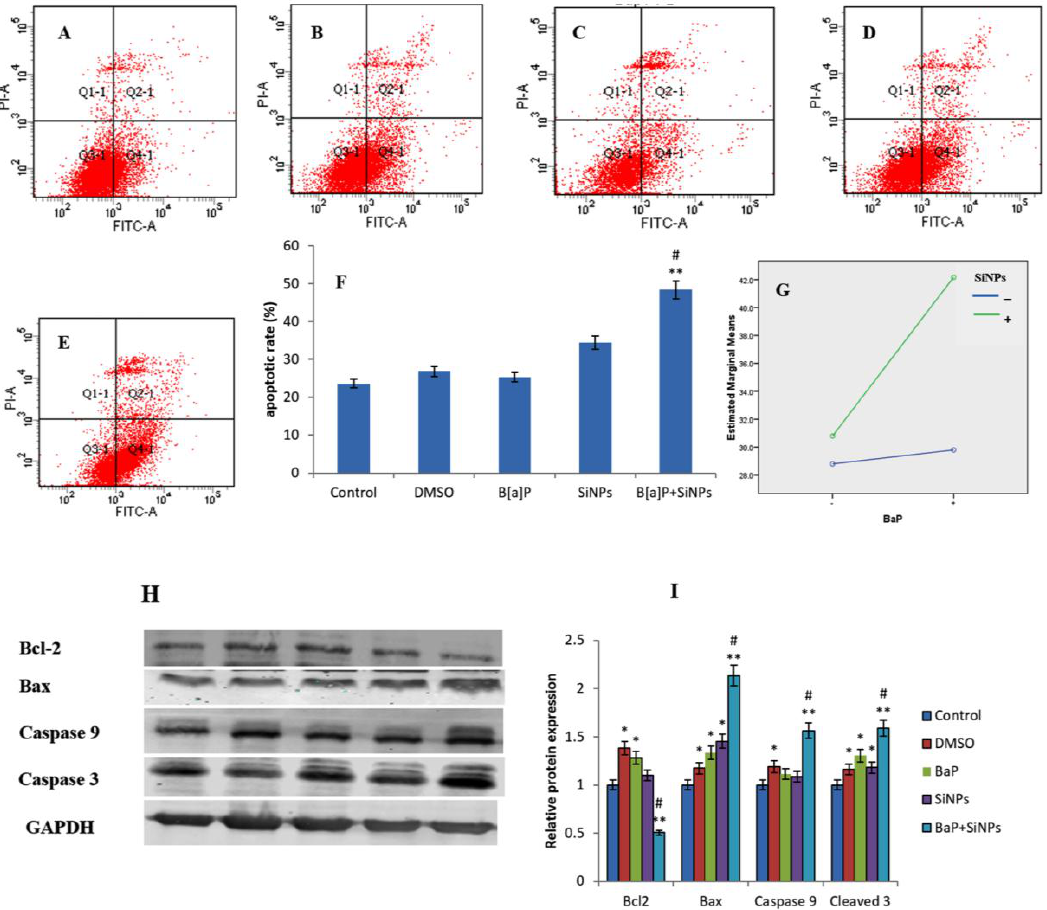
Figure 8. Apoptosis of HUVECs induced by SiNPs and/or B[a]P. ( A ) Control; ( B ) DMSO; ( C ) B[a]P; ( D ) SiNPs; ( E ) B[a]P + SiNPs; ( F ) The percentage of apoptotic cells; ( G ) Synergistic interaction between SiNPs and B[a]P illustrated by interaction plots ( F = 23.838, p = 0.001. * p < 0.05, ** p < 0.01 for the treated group compared to the control, while # p < 0.05 for the combined group compared to single treated groups; ( H ) Western blot results show a decrease in Bcl-2 expression and increase in Bax, Caspase 9, and Caspase 3 expression in the co-exposed group; ( I ) the graph shows a significant change in the protein expression of the co-exposed group compared to the other groups.